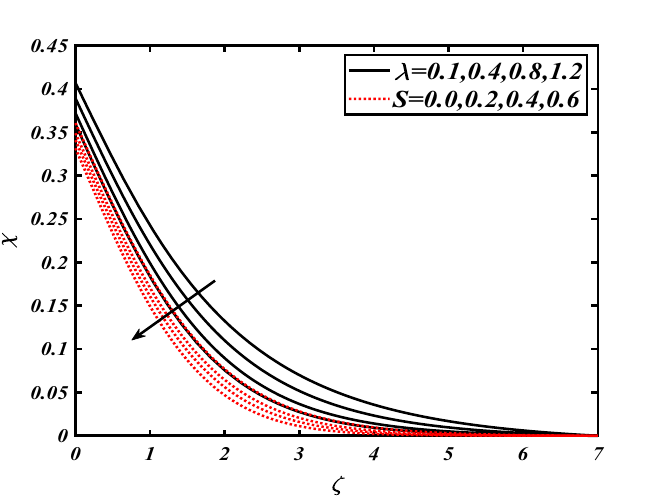
Figure 15. Illustration of (cid:31) and S over motile microorganisms χ when Rd = 0.4, γ 2 = 0.3, γ 1 = 0.3, Nr = 0.2, Pe = 0.1, Lb = 2.0